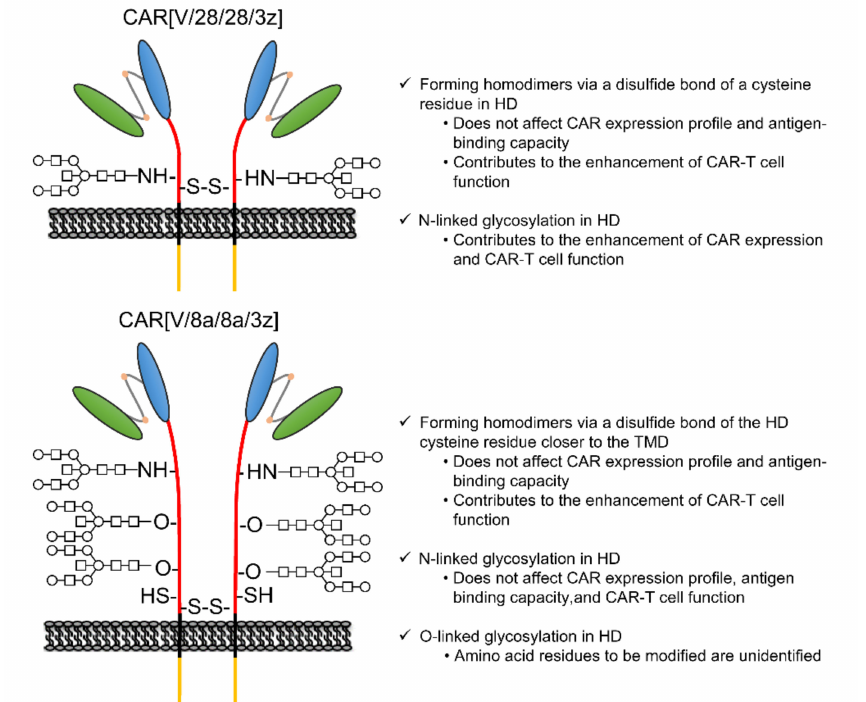
Figure 5. Role of disulphide bonding via cysteine residue and glycosylation in the HD on CAR[V/28/28/3z] and CAR[V/8a/8a/3z] expression and